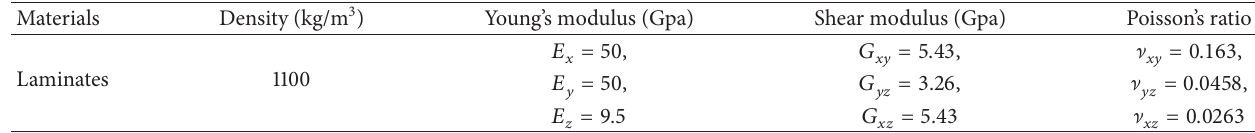
Table 1: Properties of the composite laminated sheet.